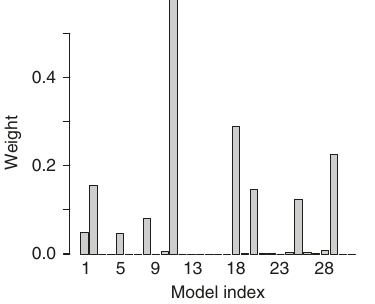
Fig. 1 Individual Coupled Model Intercomparison Project phase 5 (CMIP5) climate model weights for the HadISST_r51_anthro experiment. The weights incorporate both model performance at capturing present-day mean September Arctic sea ice extent and its sensitivity to global mean surface temperature. The experiment assumes that recent sea ice extent decline was solely anthropogenic. This fi gure illustrates the capacity of the proposed method to fi nd probabilities (weights) for any individual hypothesis in a given hypothesis set. In this case, each hypothesis is that